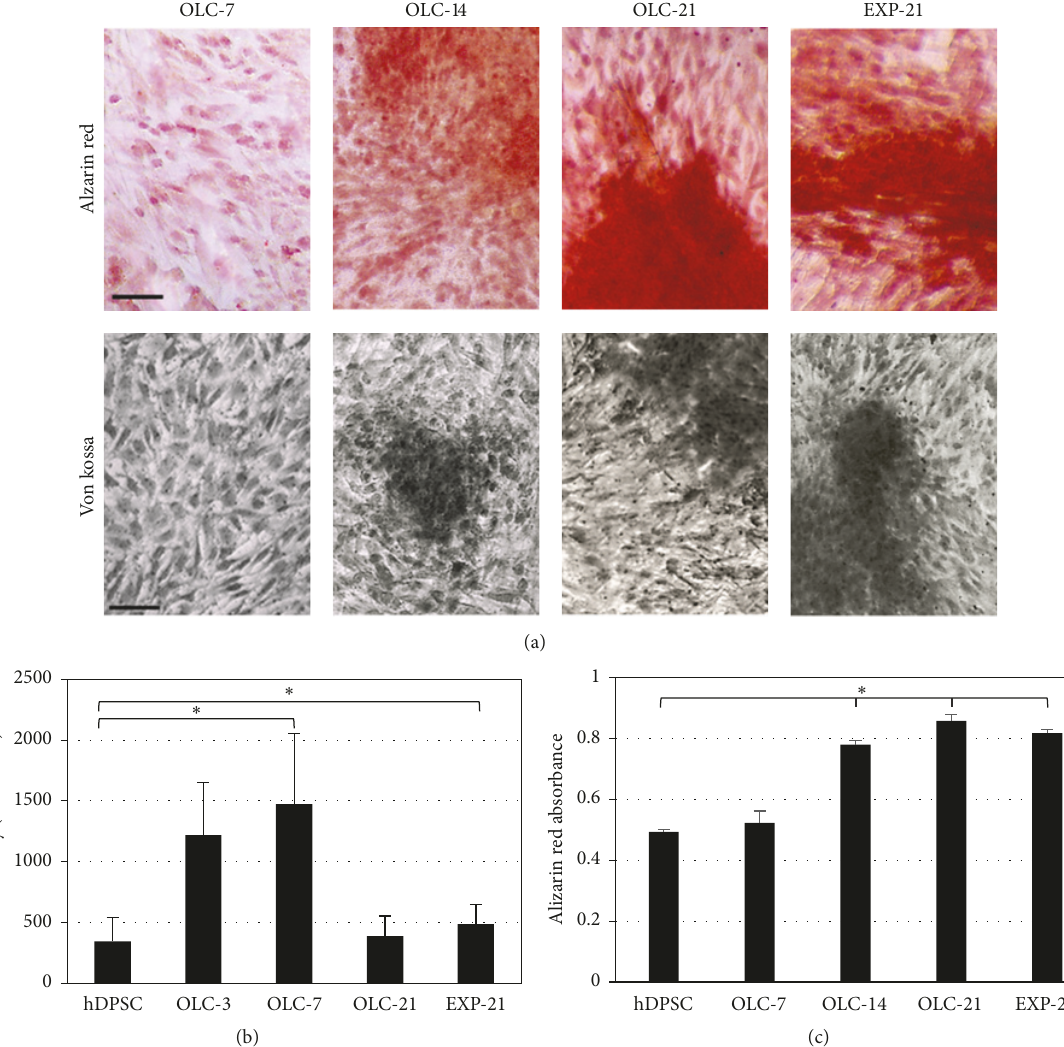
Figure 8: Extracellular matrix mineralization . (a) Mineralization was determined by alizarin red (upper panel) and von Kossa staining (lower panel). The strong staining of matrix indicates the apparent formation of calcification nodes. Scale bar: 100 𝜇 m. (b) The ALP activity as early marker of differentiation was associated with progressive mineralization of the extracellular matrix. Data shown are the mean ± SD of six replicas of three independent experiments ( 𝑛 = 18 ). Asterisks show significant differences with respect to negative control (hDPSC) ( 𝑝 < 0.05 ). (c) Absorbance measurement of alizarin red stain extracted at different stages of differentiation. Data shown are mean ± SD of six replicas of three independent experiments ( 𝑛 = 18